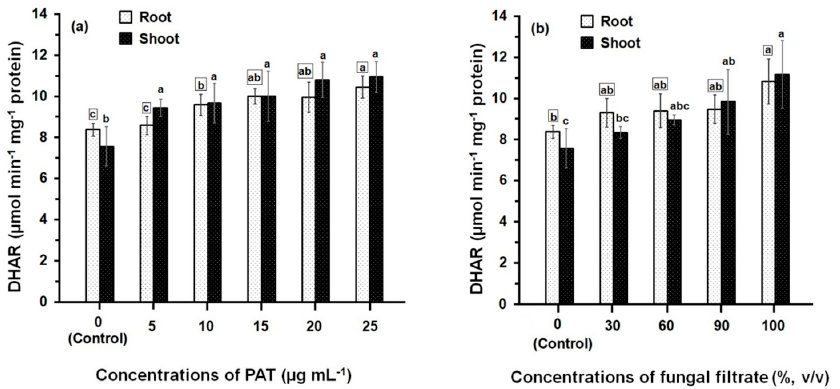
Figure 4. DHAR activity in root and shoot of 8-day-old maize seedlings treated with different concentrations of PAT ( a ) and fungal filtrate ( b ). Data are shown as the mean ± SD of triplicate measurements from three independent experiments. Different letters either for roots (in small squares) or shoots (without squares) at different concentrations are statistically different (LSD test, p ≤ 0.05). Treatment of maize seedlings either with PAT or fungal filtrate concentrations led to an increase in MDHAR activity (Figure 5). The greatest effects were observed with high concentrations (between 10 μ g·mL − 1 and 25 μ g·mL − 1 in the case of PAT and between 60% and 100% in the case of fungal